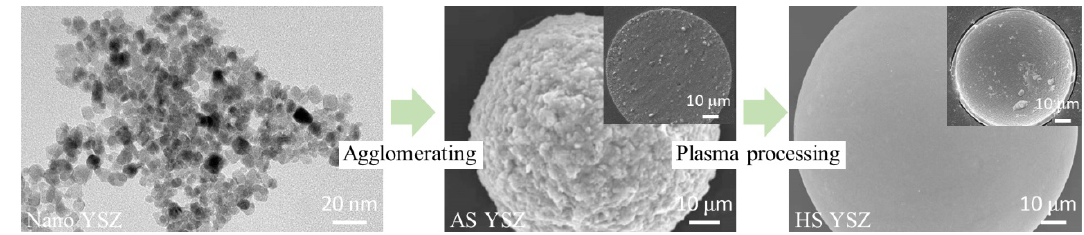
Fig. 5 Scanning electron microscopy (SEM) images of YSZ powders with different